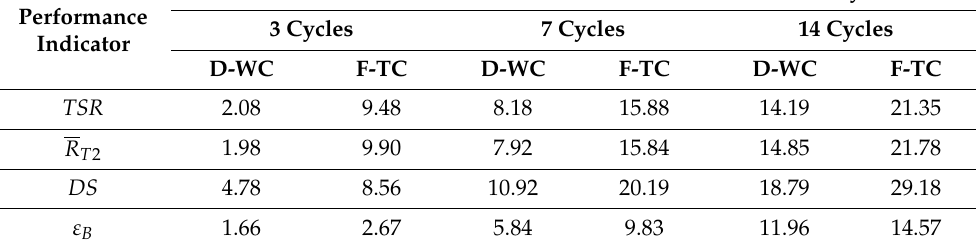
Table 4. Decrease rate of each performance index with the number of dry–wet cycles and freeze– thaw cycles.